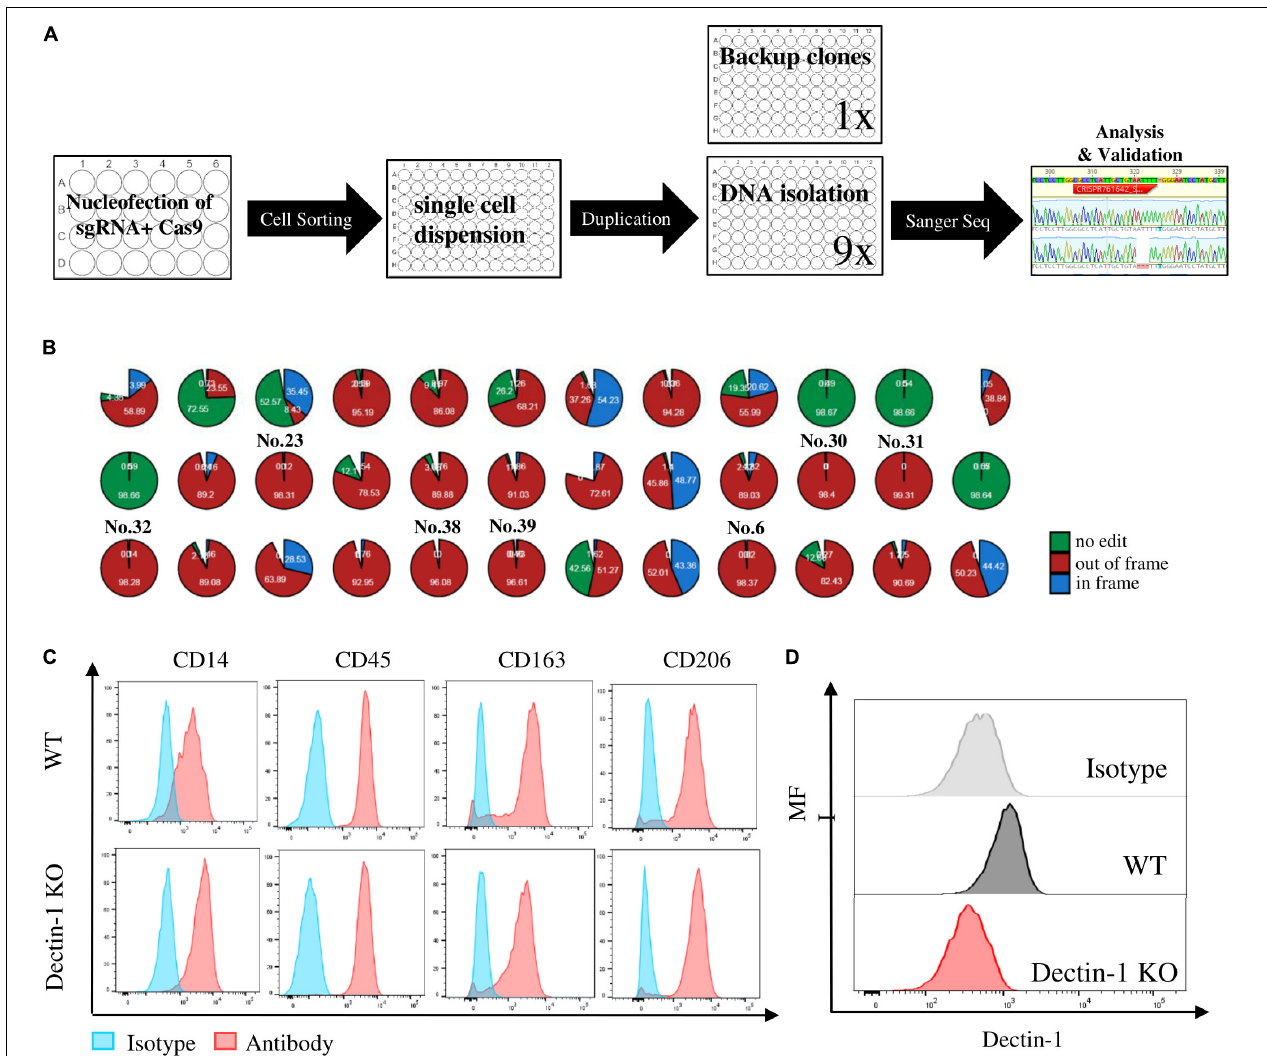
FIGURE 5 | Crispr/Cas knockout (KO) and of immune regulatory receptors in human induced pluripotent stem cells (hiPSCs) and functional analysis of macrophages derived from relative KO clones. (A) Workstream scheme for generating and analyzing of single cell KO clones in hiPSC. (B) Eight out-of-frame homozygous Dectin-1 KO clones were identified by Sanger sequencing and interference of CRISPR edits (ICE) analysis. (C) Macrophage marker expression level between wild type (WT) and Dectin-KO clone No. 32-derived macrophages. (D) Dectin-1 expression level and relative isotype in macrophages derived from WT and Dectin-1 KO clone No.